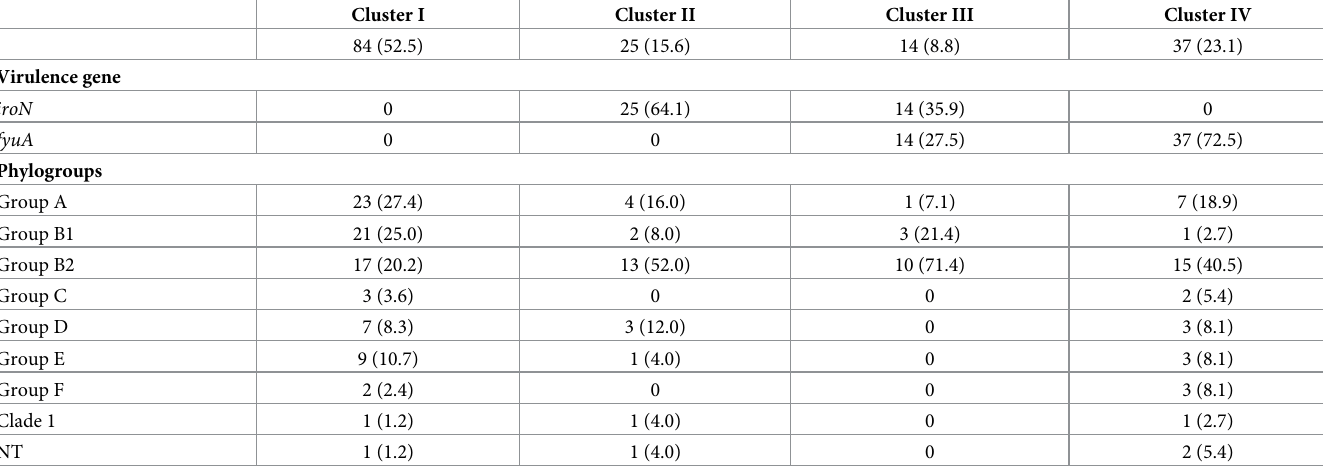
Table 9. Hierarchical clustering for distribution of iron acquisition virulence genes among E . coli isolated from ASB cases, total